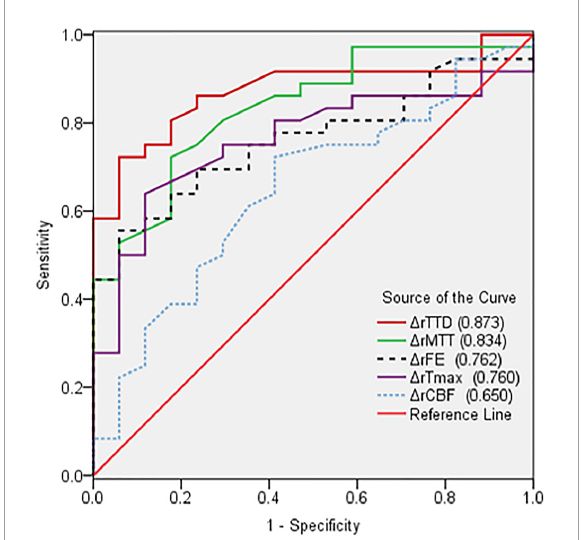
FIGURE3 Comparison of receiver operating characteristic curves based on the changes in the relative CTP parameters ( (cid:49) rCTP) pre- and postoperation. (cid:49) rTTD had the largest AUC (0.873) among all